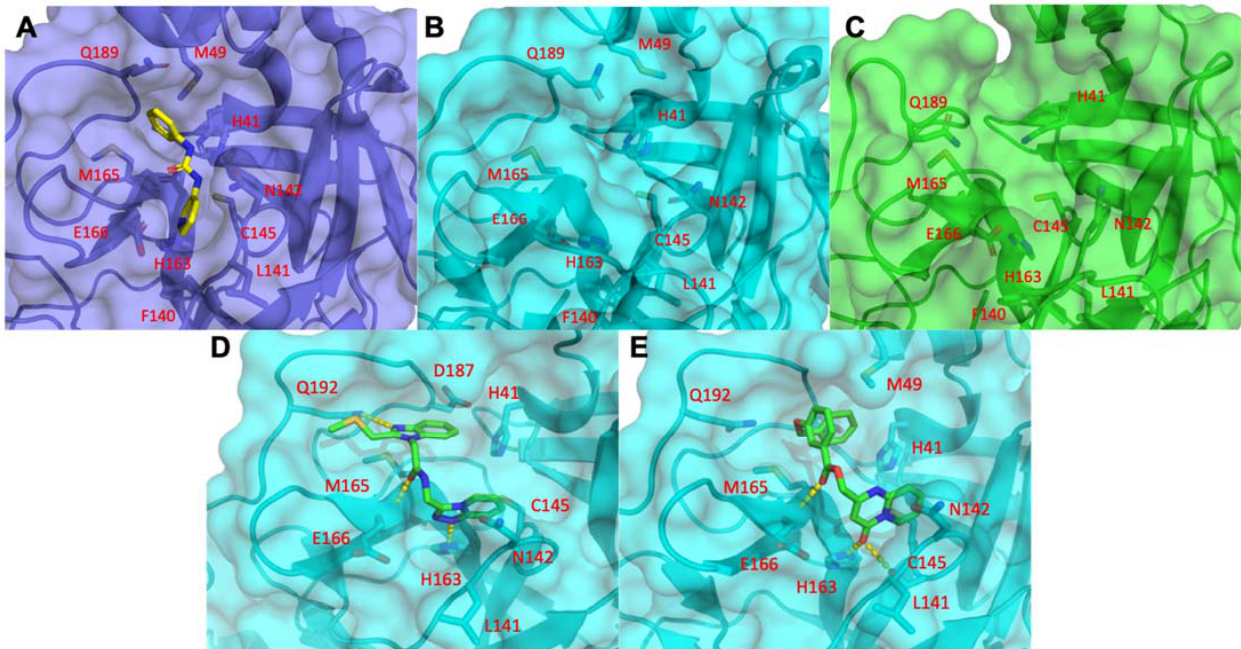
Figure 6. Druggability of M pro is demonstrated with detailed analysis of α -Keto amide group binding using MD simulations. ( A ) The M pro crystal structure PDB ID: 5R83 bound to compound containing an α -Keto amide group flanked by hydrophobic groups is shown. Sufficient structural stability of the binding site is demonstrated via comparative visualization of initial ( B ) and final ( C ) states of MD. Binding site retains its geometry and shape across the MD. Two bound states of hit compounds from the large library of compounds give further exemplars: compound 120 ( D ) and compound 247 ( E ) (Z2169338256 and Z991010090) in complex with M pro protein.